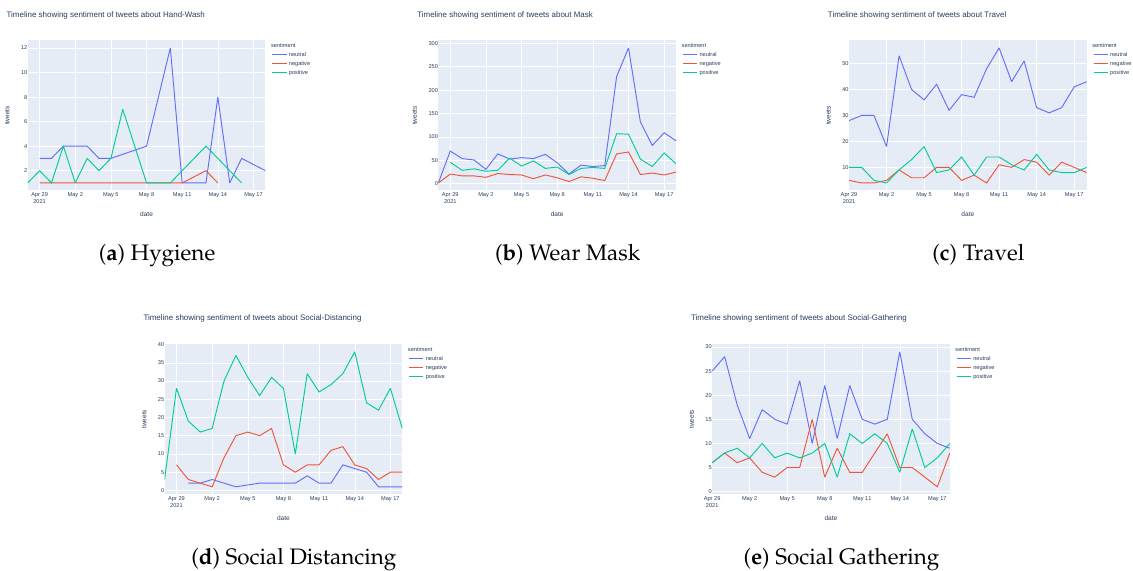
Figure 10. Public sentiment for Twitter Dataset 2 on healthy lifestyle with timeline using